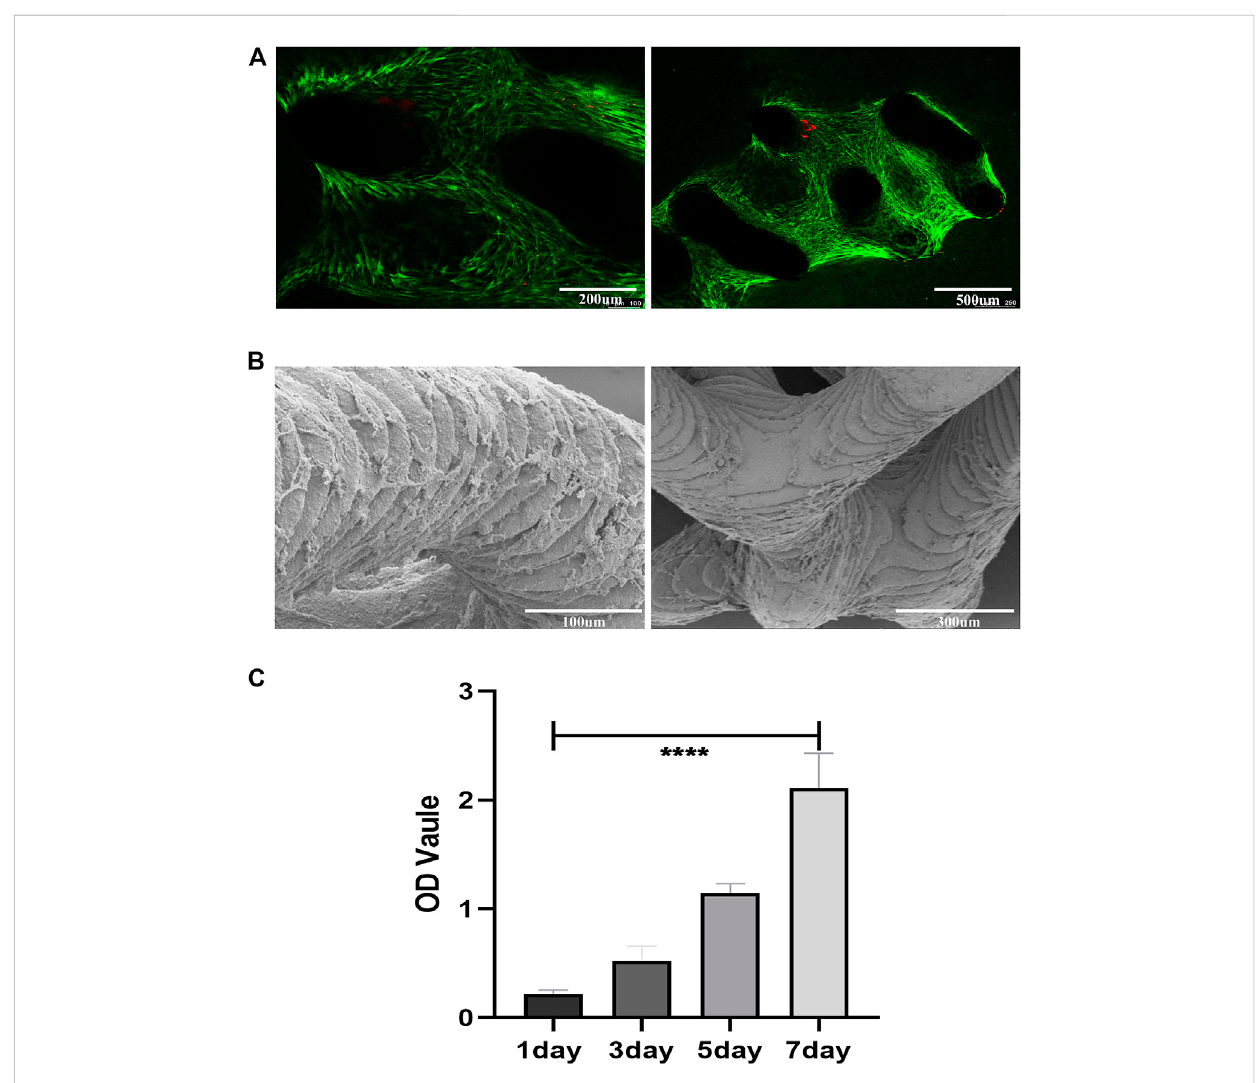
FIGURE 6 Cell adhesion, growth, morphology and viability on the porous scaffolds. (A) Live/Dead staining of SCAPs on the scaffolds after 14 days of culture; green represents living cells, red represents dead cells (B) SEM images of the SCAPs morphology on scaffolds after being cultured for14 days (C) SCAPs adhesion and proliferation on